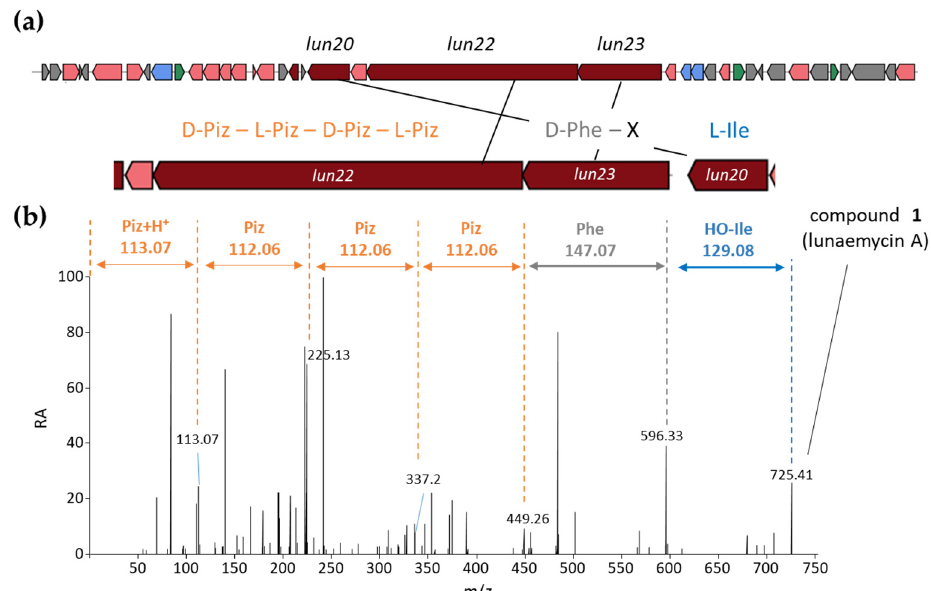
Figure 3. HRMS/MS-based identification of the amino acid building-blocks of compound 1 . ( a ) NRPS genes of BGC 28a ( lun cluster) and the predicted amino acid building-block sequence. ( b ) MS fragmentation spectrum and proposed structure of compound 1 (lunaemycin A). Only fragments corresponding to amino-acid or peptide m / z of the predicted peptide sequence are highlighted. Color code: orange, piperazic acid (Piz); grey, phenylalanine (Phe); blue, hydroxylated isoleucine (HO-Ile).